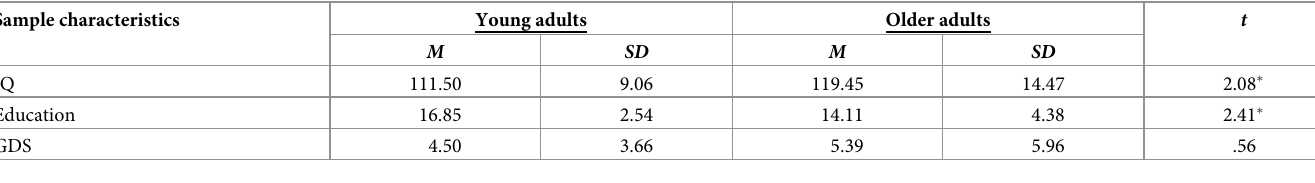
everyday memory) and one laboratory episodic memory task, which was intended as a bench- mark for performance. The tasks measured memory for different types of experience (i.e., high or low in personal significance and distinctiveness), involved different retrieval cues (event title, time period, generic word) and different retention intervals (seconds, days, months, years). Two of the tasks specified precisely what the participant was required to recall (every- day memory, word list recall), while the others allowed participants to choose which events to describe. A comparison of selected features of each task is presented in Table 3. Tasks were administered in the same order for all participants, as follows: (1) Word List Recall; (2) Age 11–17 AM; (3) Past Year AM; (4) Word-cued AM; (5) Everyday Memory. Following this task order meant that the retrieval cues increased in specificity across the test session, which was intended to minimise the opportunity for specific cues from one task to prime retrieval of AMs in a different task. The advantages and disadvantages of this approach are discussed later. Word list free recall. For this task participants were presented with a list of 25 unrelated common English nouns presented in lower case, in black font on a white computer screen at a rate of 5s per word. The presentation was deliberately slow in order to minimise the influence of processing speed as a confounding variable, since older adults’ processing speed is typically reduced [35]. Word characteristics were obtained from the MRC Psycholinguistic Database [36]. The selected words all had 5 letters, two syllables, concreteness ratings of between 500 and 650 and familiarity ratings of between 450 and 550 (both concreteness and familiarity scales range from 100 to 700). From the original pool of 56 words, 10 were excluded because (a) they differed by only one letter from another word in the list (e.g., daisy / dairy ; one of each pair was excluded at random), (b) the word was much less common in British English than American English (e.g., burro ; confirmed using Google Ngram Viewer 2009 corpora), (c) had different meanings in British and American English (e.g., jelly ), or (d) pronunciation was highly irregular (e.g., choir ). Of the remaining 46 words, 25 were randomly selected for inclu- sion (see OSF project page for full list: https://osf.io/9wxyz/). Immediately after presentation of